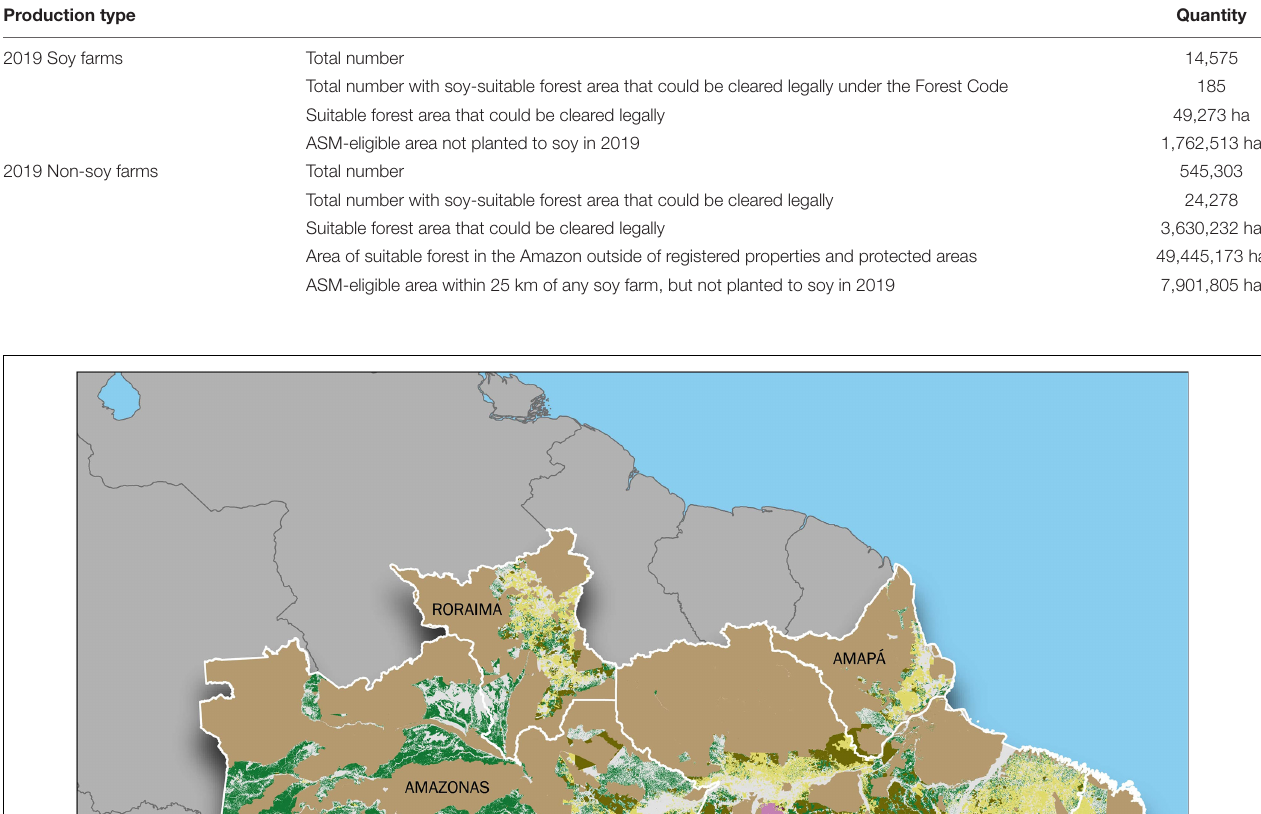
TABLE 1 | Summary of property-level land cover estimates.